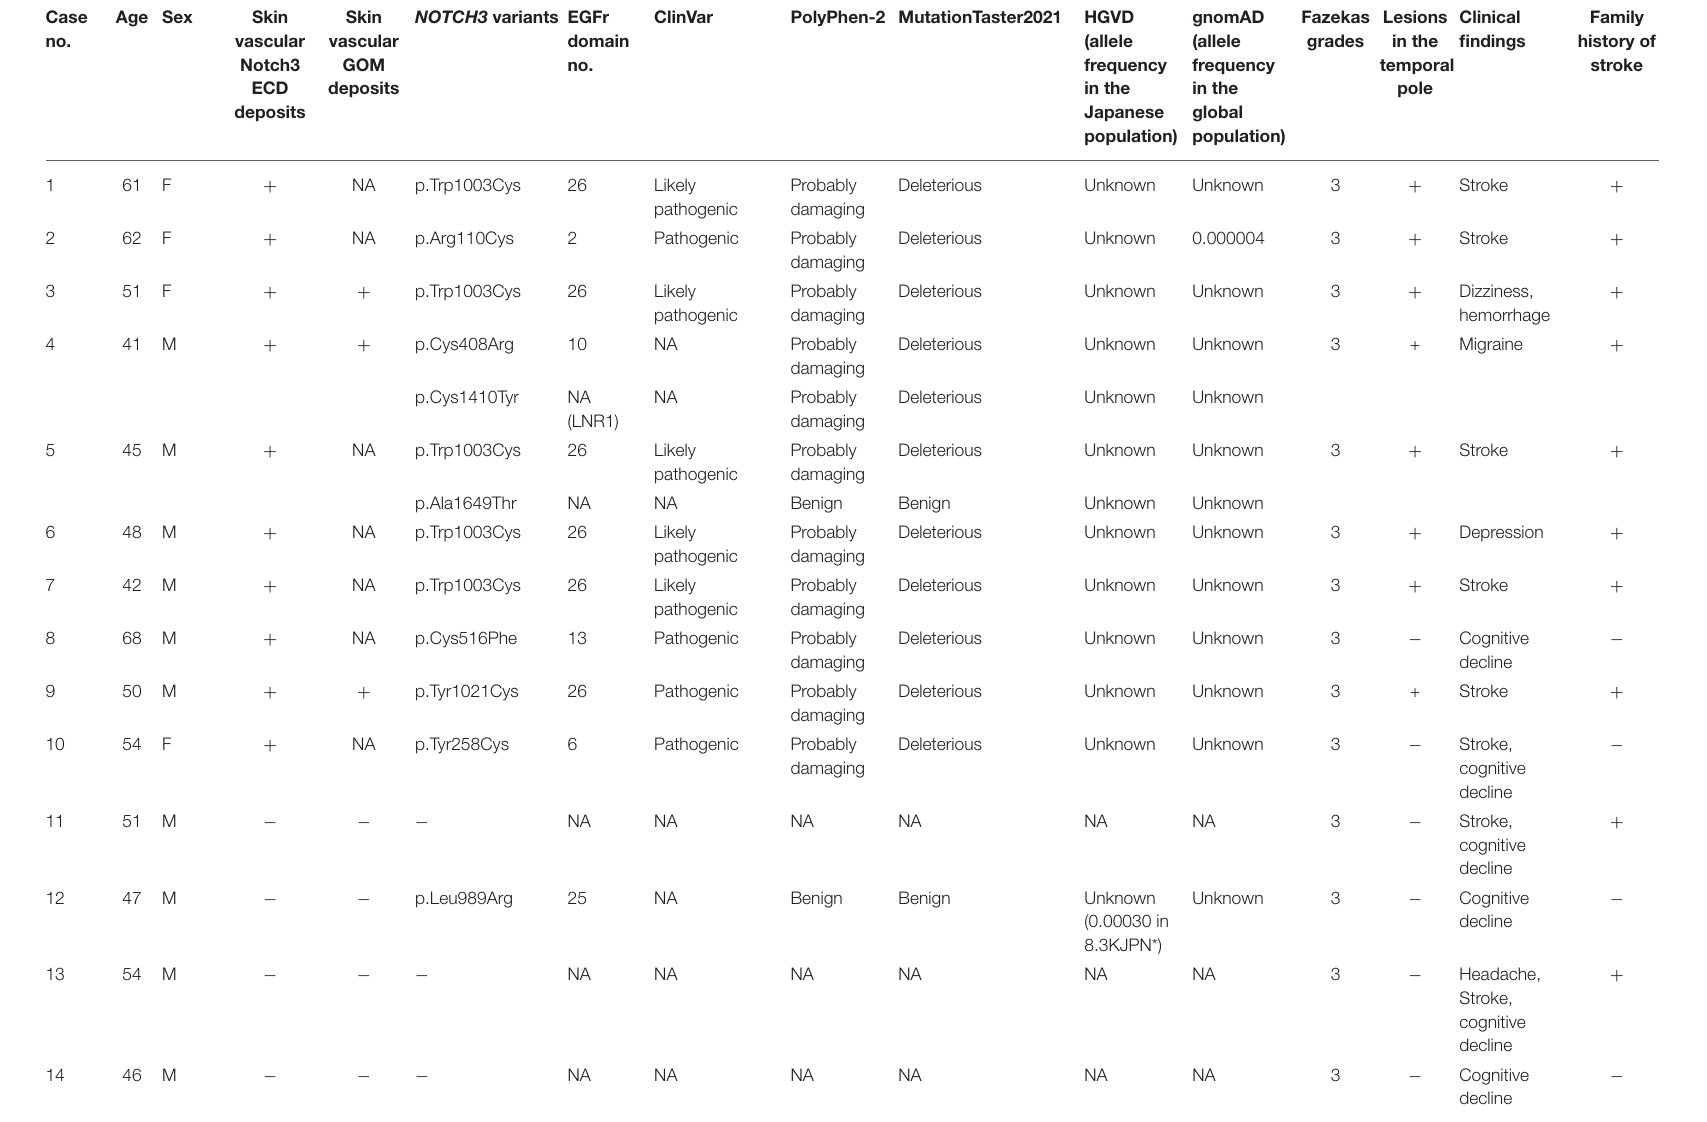
TABLE 1 | Skin vascular Notch3 ECD deposits and NOTCH3 variants in 43 patients with suspected CADASIL. Case